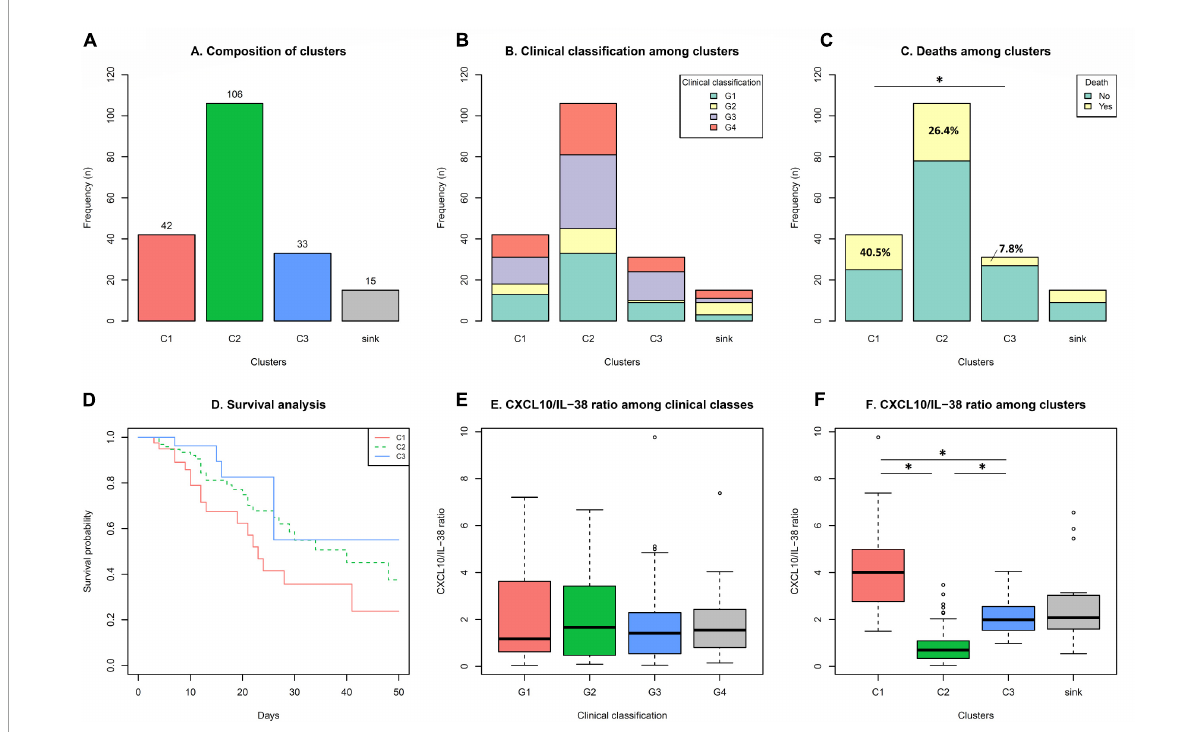
FIGURE3 Clinical classification and mortality among the clusters. Considering cluster compositions (A) , analysis of: clinical classification (B) , mortality (C) , and survival (D) among the clusters was performed. CXCL10/IL-38 ratio in the clinical classification groups (E) and among the clusters (F) was analyzed. Statistical analysis using Chi-square was performed excluding the sink group. *Significant differences were found in: Mortality C1 vs. C3 p < 0.05; CXCL10/IL-38 ratio among clusters C1 vs. C2 vs. C3 p <